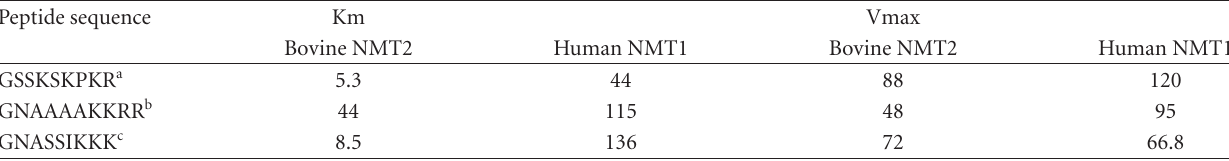
Table 1: Peptide substrate specificity of the recombinant bovine brain NMT2. The recombinant bovine brain NMT2 assay was measured in the presence of varying concentrations of various peptide substrates (0–1000 μ M). The reaction was carried out as described in Section 2. The data shown represent the mean of three replicates. The human NMT1 values were adopted from [28]. Peptides derived from known mammalian N -Myristoyl proteins.